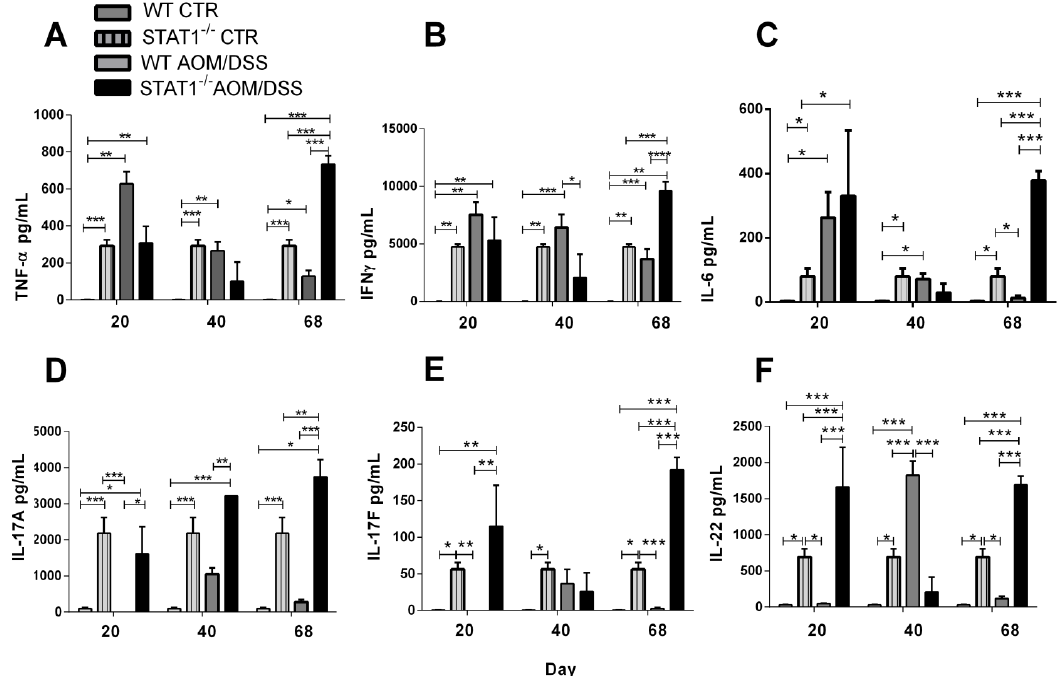
Figure 8. The deficiency of STAT1 alters cytokine production during CAC development. ( A ) TNF- α , ( B ) IFN- γ ; ( C ) IL-6; ( D ) IL-17A; ( E ) IL-17F; and ( F ) IL-22 cytokine production from splenocytes of control or CAC-induced WT and STAT1 − / − mice stimulated for 48 h with anti-CD3 antibody. Data are expressed as mean ± SEM and are representative of two independent experiments with at least three mice per group per day of the analysis. * p < 0.05, ** p < 0.01, *** p < 0.001.